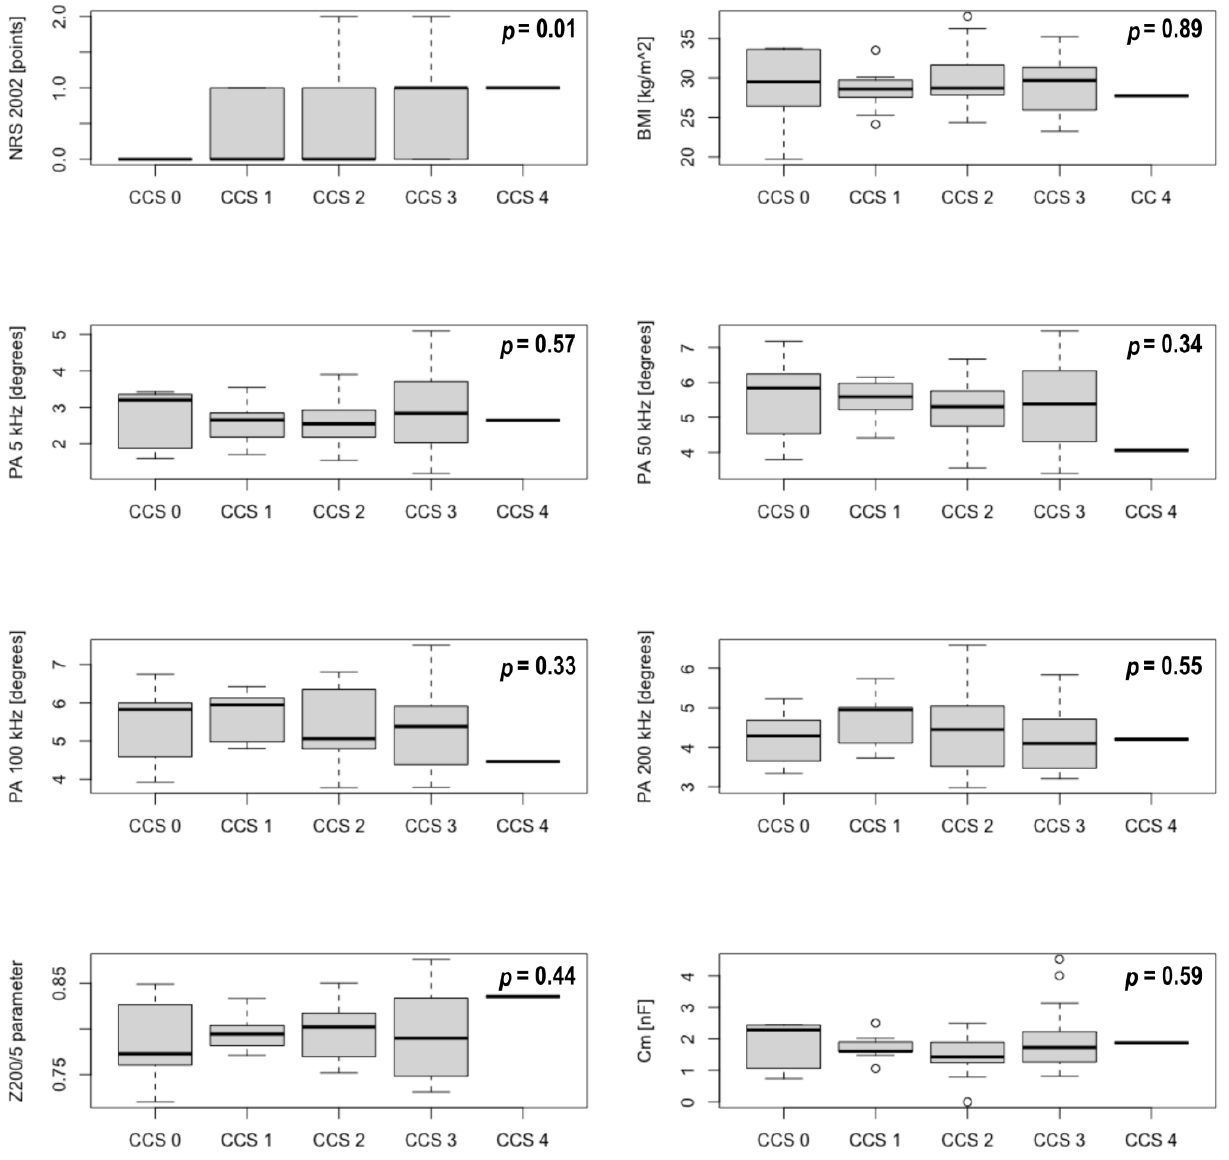
Figure 1. Box-plots presenting differences in nutritional parameters between consecutive CCS class subgroups.